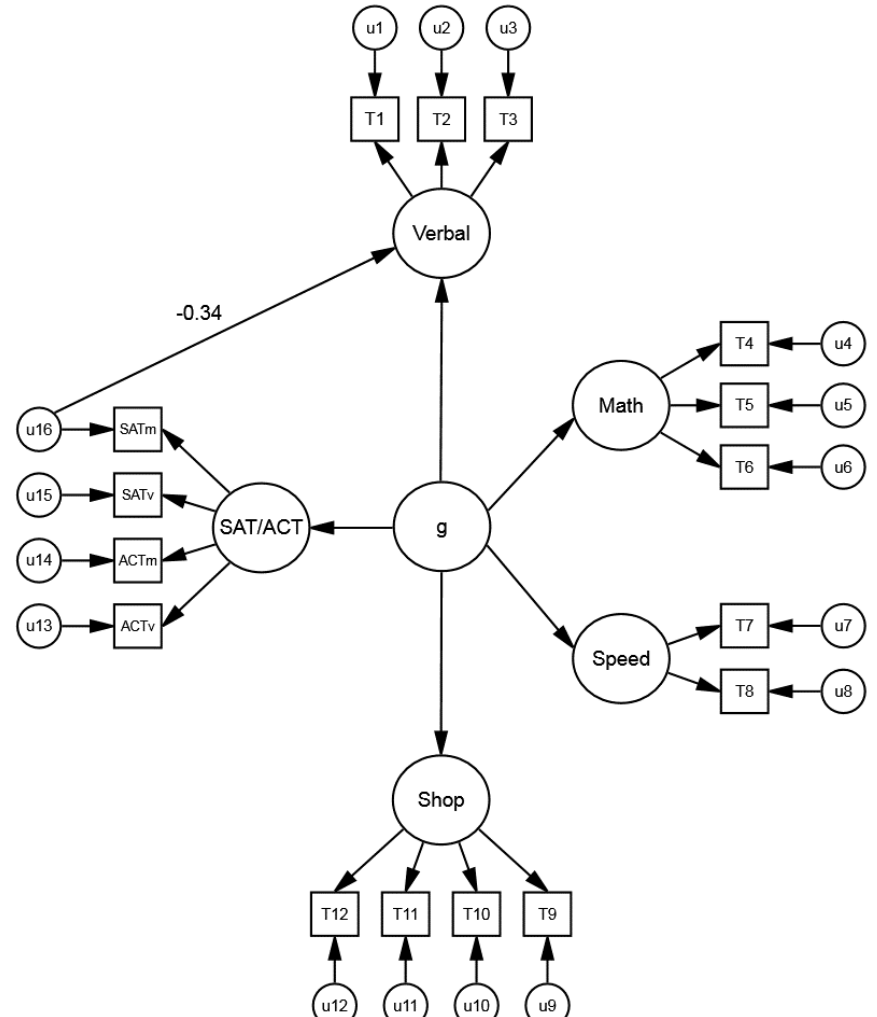
Figure 2 . Model of g with the SAT subtests, ACT subtests, ASVAB abilities. The symbol “u16” represents the SAT math non- g residuals (based on the math subtest), obtained after removing g . The u16 → Verbal path estimates the relation of the SAT math non- g residuals with ASVAB verbal ability ( β = − 0.34). Figure adapted from Coyle et al. [15].